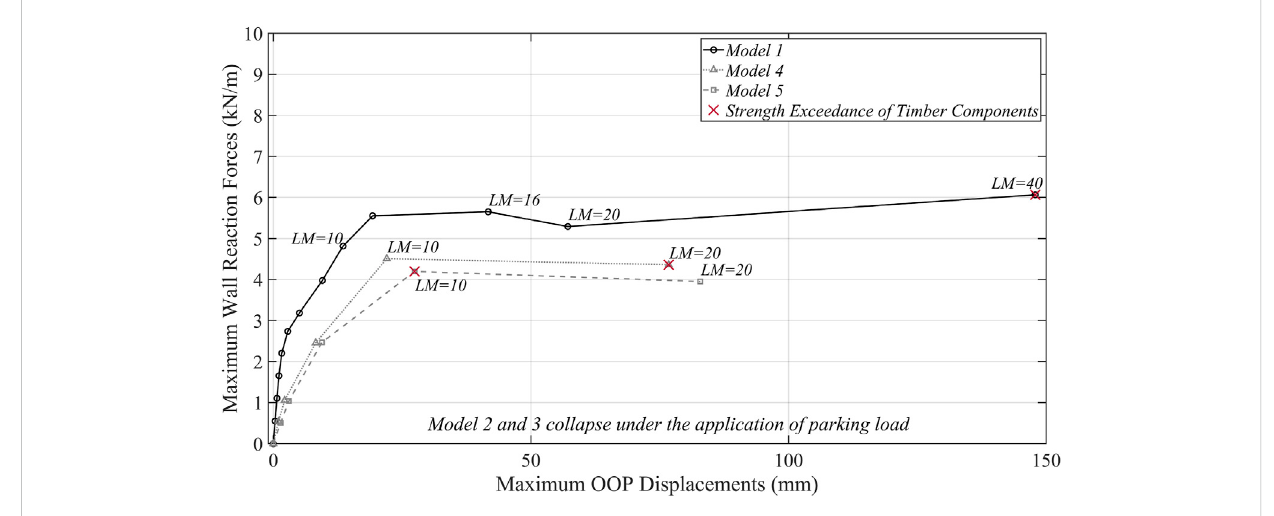
FIGURE 14 Maximum wall reaction force vs. maximum out-of-plane displacement curves for undamaged and damaged foundation